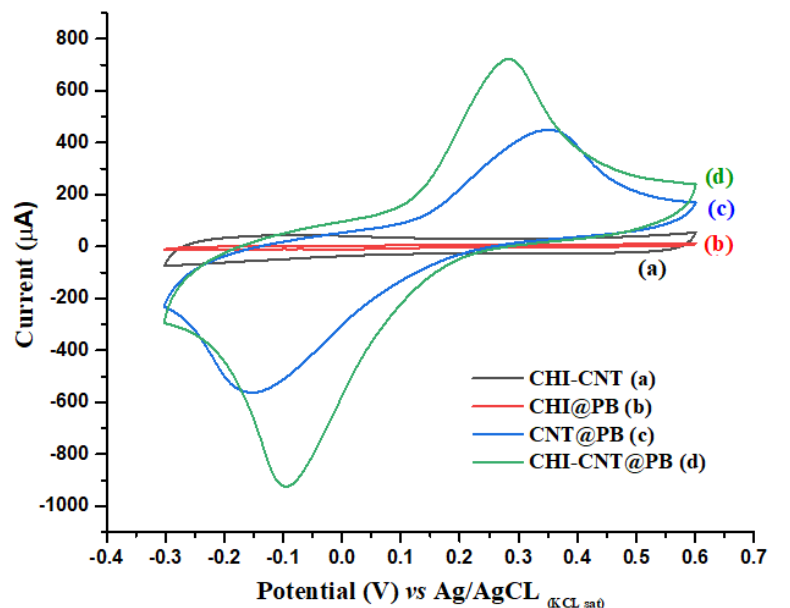
Figure 2. Cyclic voltammograms at 0.1 V · s − 1 scan rate with different film compositions: ( a ) CHI–CNT, ( b ) CHI–PB, ( c ) CNT–PB, and ( d ) CHI–CNT@PB. Measurements were performed in the presence of KCl (100 mmol · L − 1 ) at a 0.05 V · s − 1 scan rate.